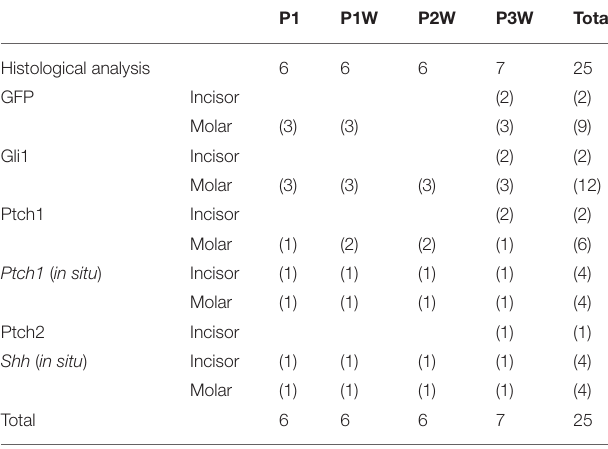
TABLE 1 | Number of animals for histological, immunohistochemical, and statistical analyses of chronological changes in GFP, Gli1-, Ptch1-, and Shh-positive cells.